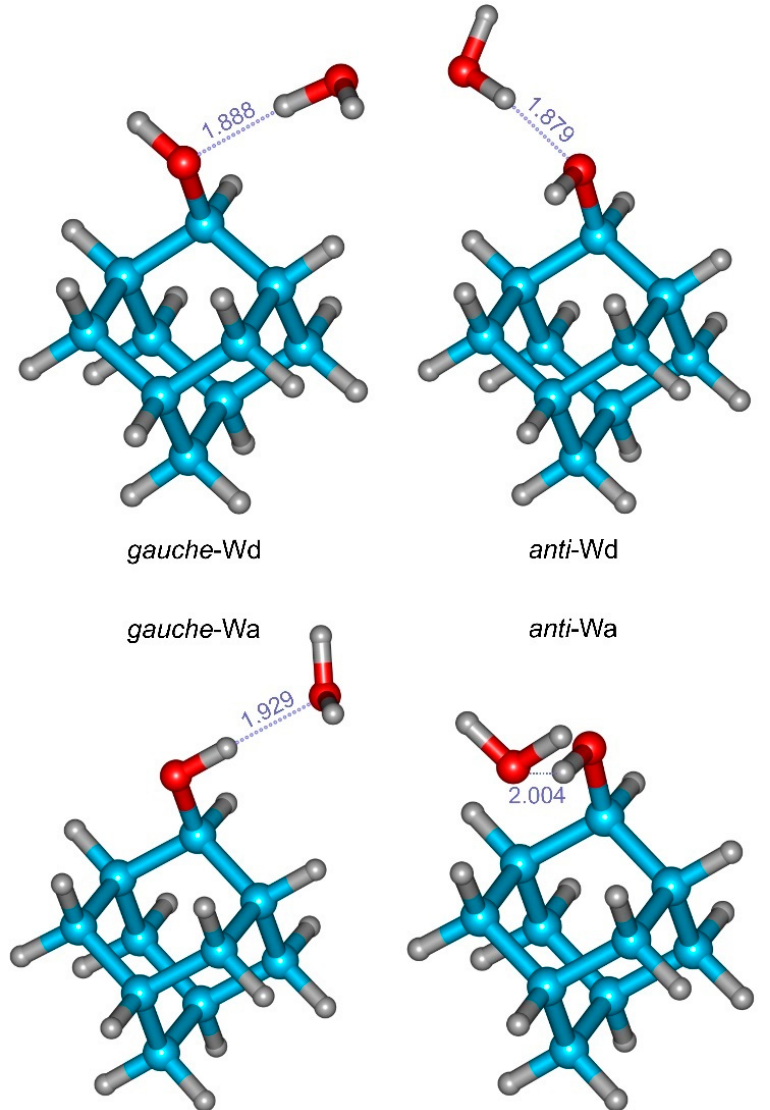
anti form ( anti -Wa). The optimized structures are shown in Figure 2, with the computational predictions collected in Table 2 (B2PLYP) and Table S3 (SM, B3LYP).